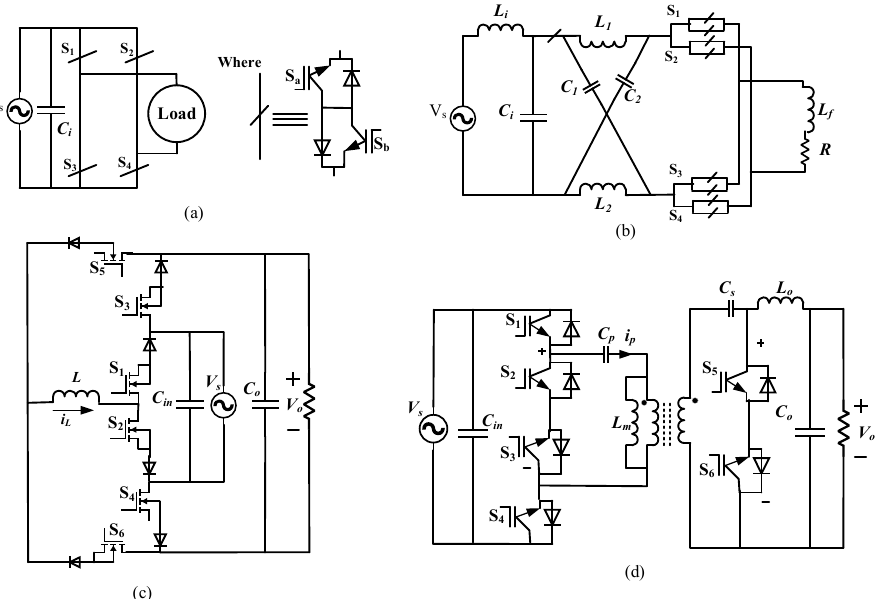
Figure 19. Types of single-phase matrix converter (MC): ( a ) conventional single-phase MC, ( b ) single-phase Z-source MC, ( c ) six-switch buck–boost MC, and ( d ) high-frequency transformer (HFT)-isolated MC. Table 9. Various types of single-phase MC topologies.